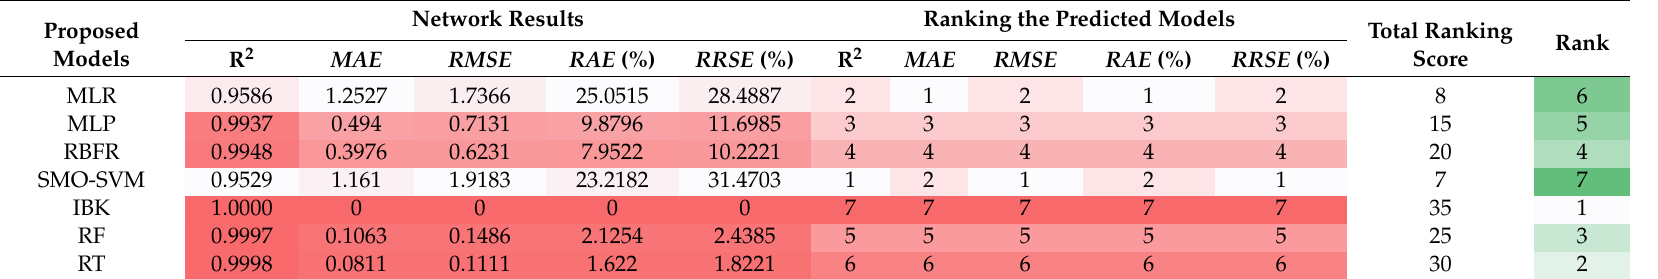
Table 3. Total ranking of the training dataset in predicting the factor of safety.